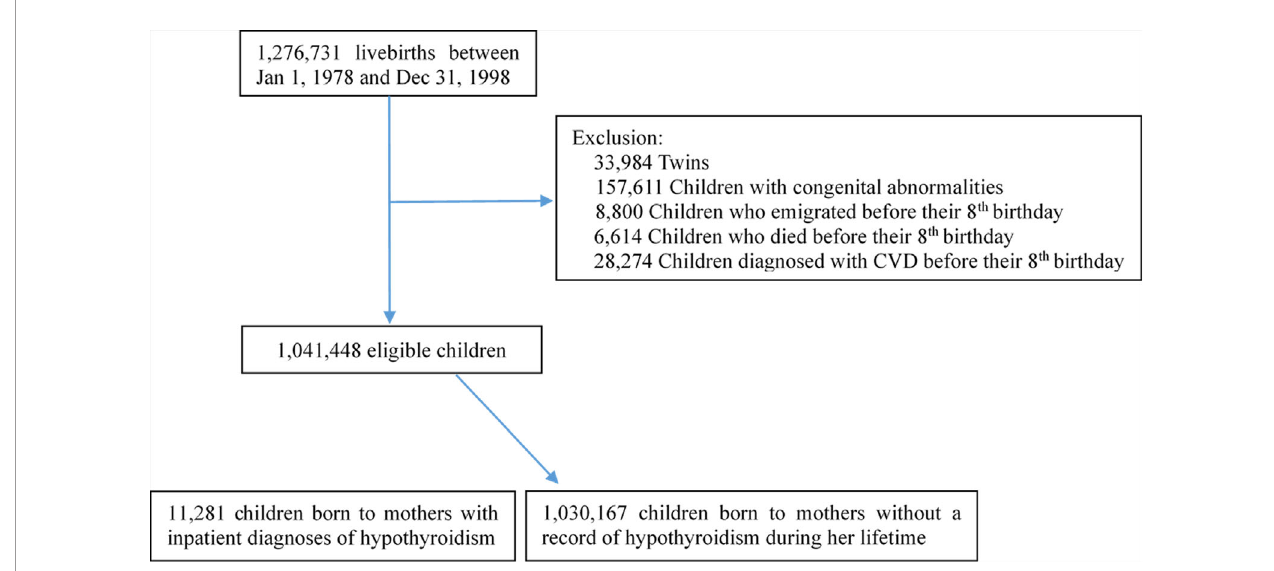
FIGURE 1 | Flow chart illustrating the identi fi cation of the study